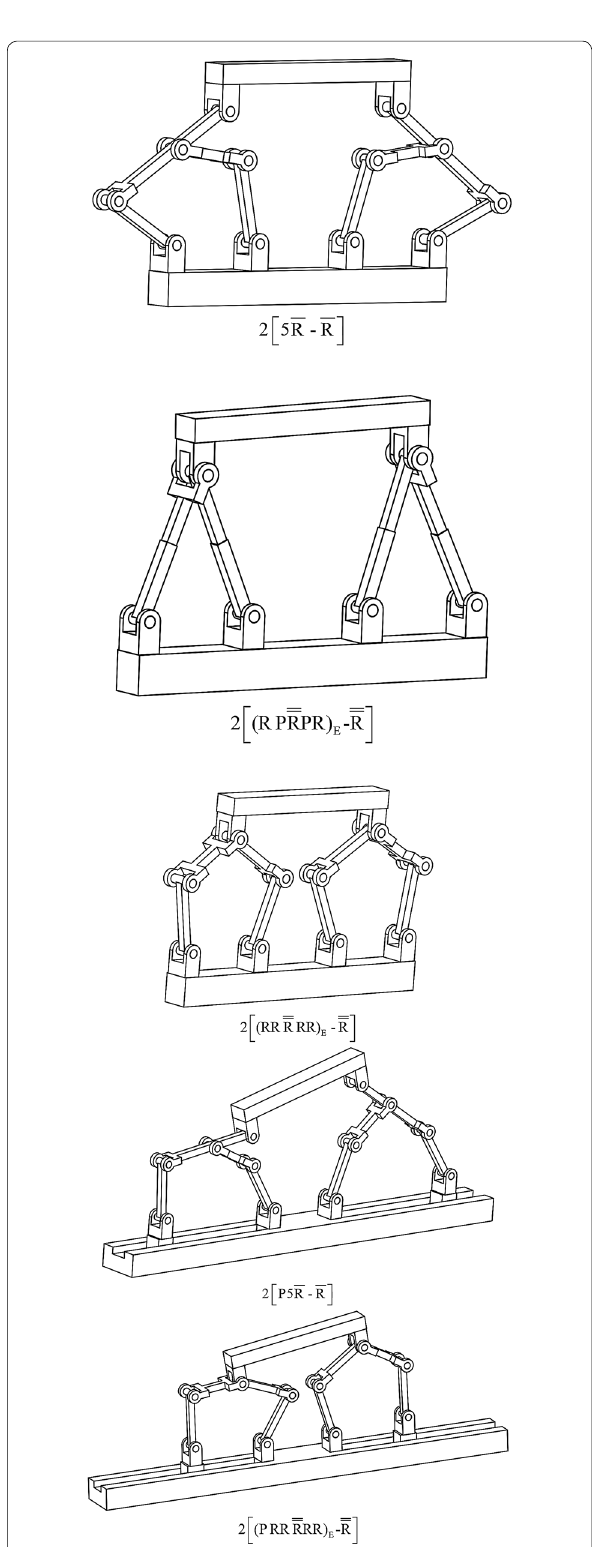
Figure 18 3D diagram of some represented parallel